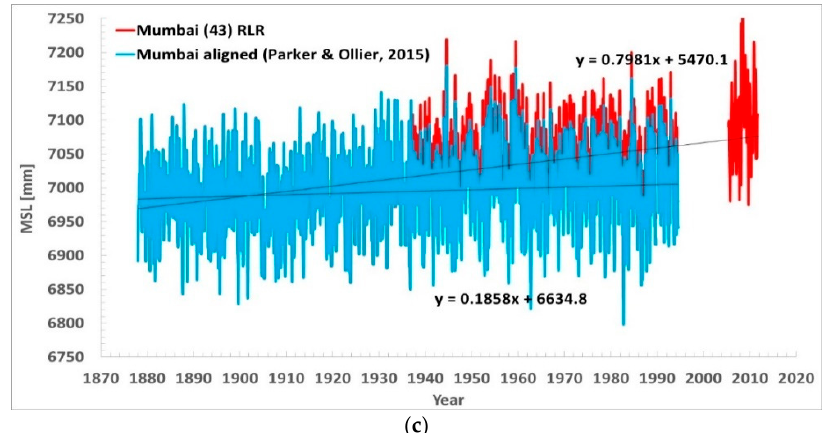
Figure 9. Mumbai. ( a ) Linear fittings applied to the five segments. ( b ) MSL aligned compared to the PSMSL RLR data. ( c ) MSL aligned the same method, but only three segments, as in [2,21], compared to the PSMSL RLR data. When measured, the sea levels were decreasing. The rising trend of the PSMSL RLR data was the result of the shifts of one segment versus the other, always upwards versus the values suggested by the alignment of the breakpoints.